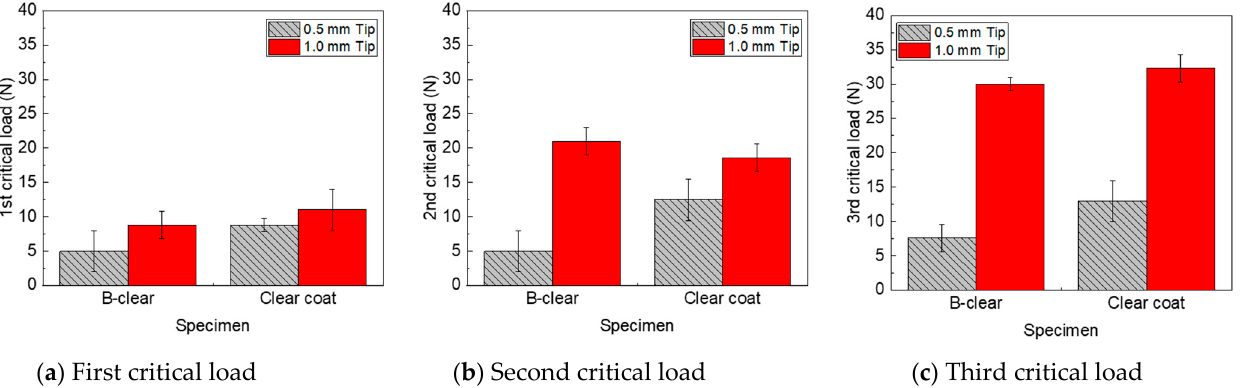
Figure 5. Comparison of scratch critical loads of commercial clear coat and B-clear specimens for various tip sizes.